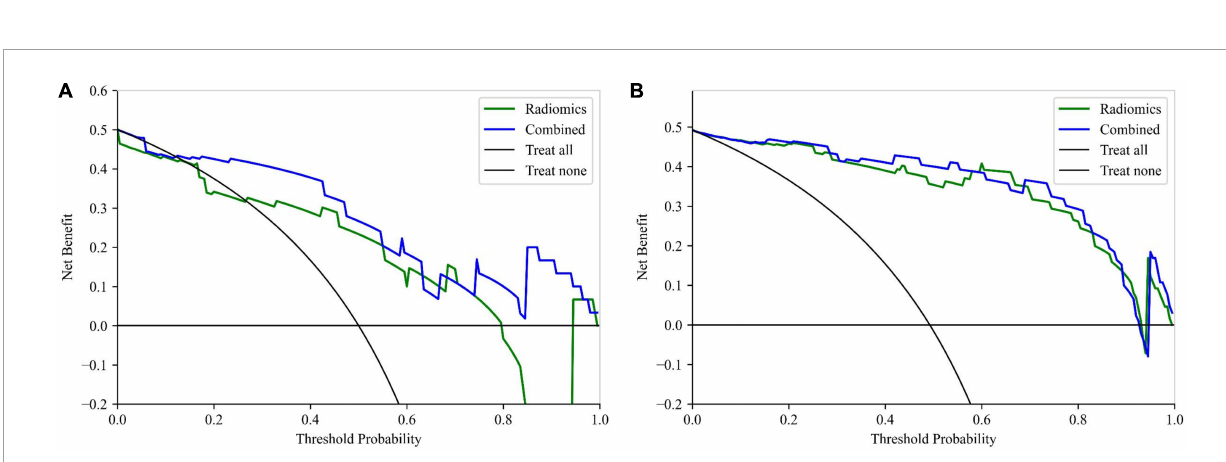
FIGURE4 (A,B) Decision curves of the radiomics and combined model on the testing cohort and training cohort, respectively.